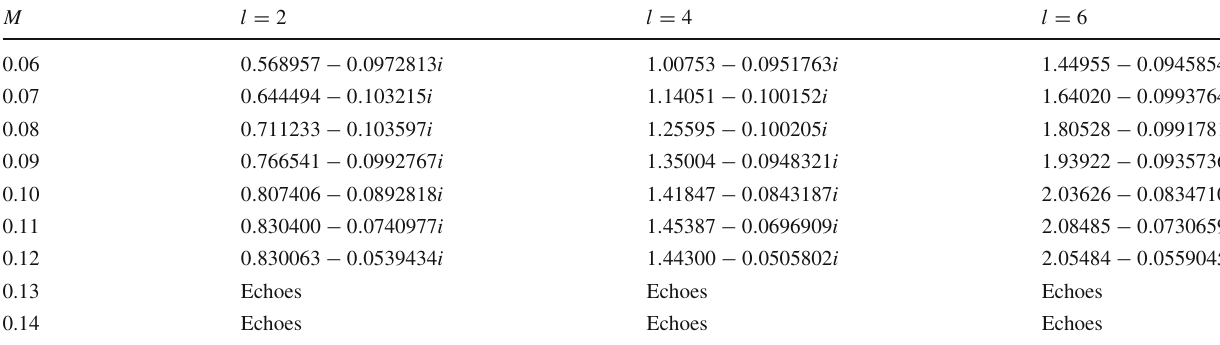
Table 2 The QNM frequencies with different M . We set Q e = − 10 ,γ 1 = − 10 ,γ 2 =